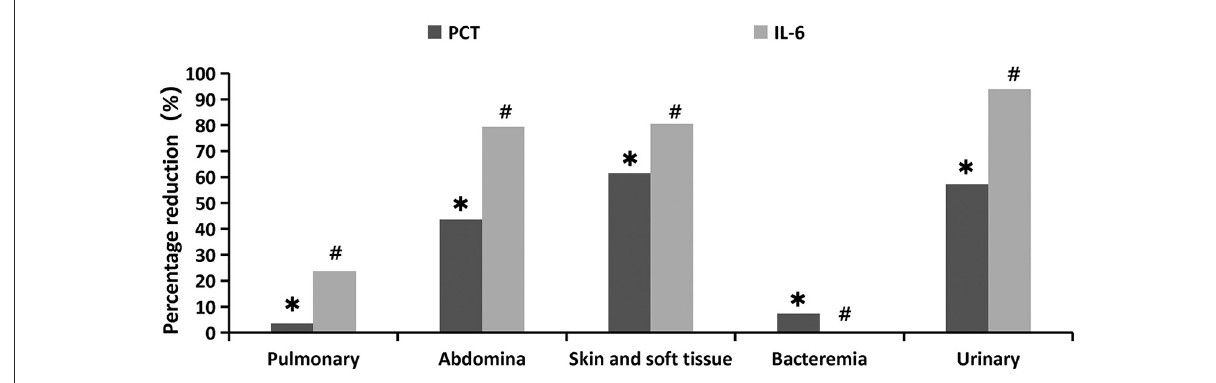
FIGURE4 Percentage reduction of infection indicators at different primary infection sites 24h after oXiris-CHFA treatment. *P = 0.035, # p = 0.001.